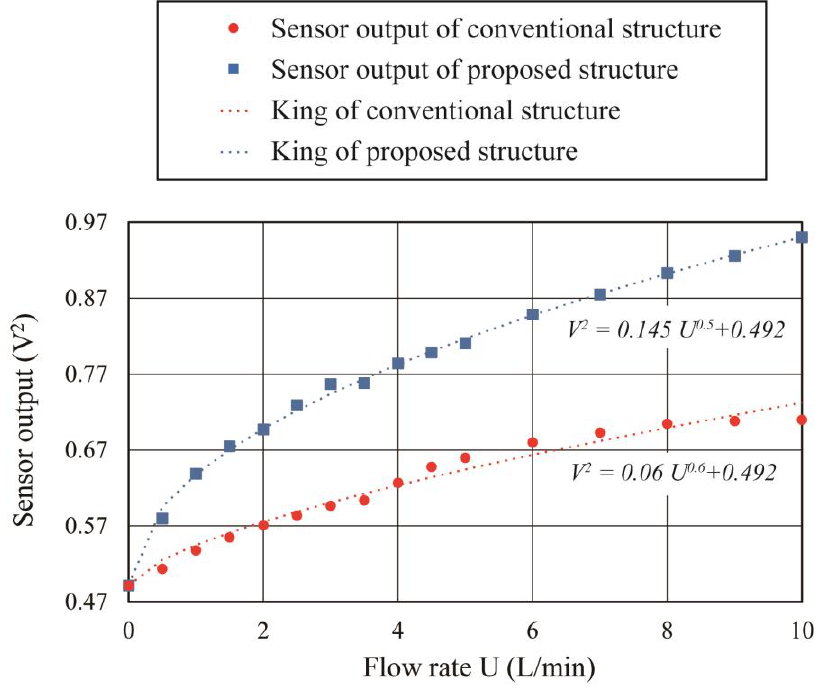
Figure 11. Flow characteristics of the conventional structure (red) and the proposed sensor (blue).